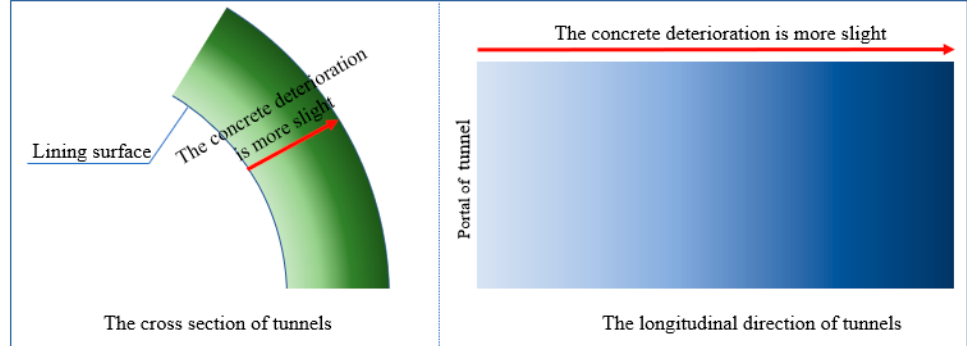
Figure 5. Deterioration rules of tunnel lining concrete.